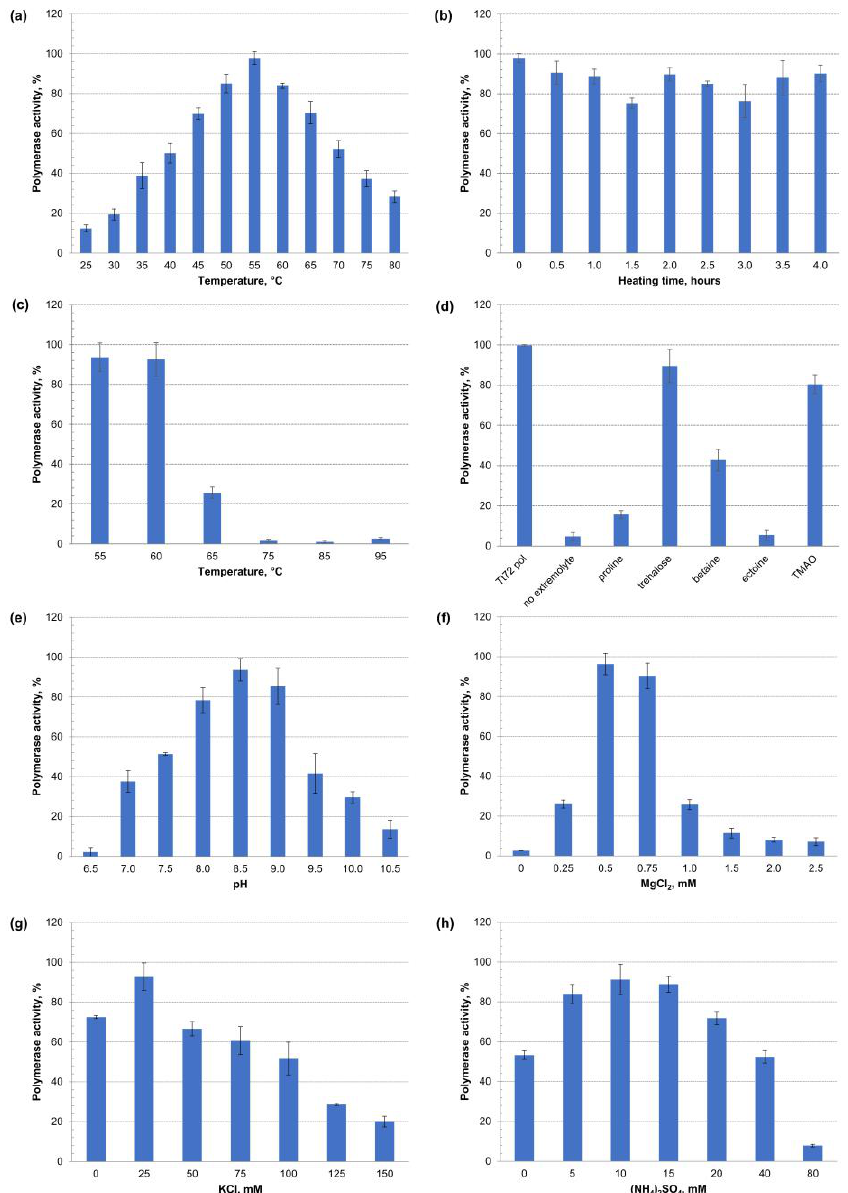
Figure 8. Characterization of Tt72 pol activity optima. Enzyme activity was estimated by measuring the incorporation of radiolabeled nucleotide [ 3 H]-dTTP into activated calf thymus DNA at 55 ◦ C; identical aliquots of Tt72 pol were assayed in three independent sample replicates for each experiment. The variable factors were ( a ) temperature (25–80 ◦ C), ( b ) heating time at 55 ◦ C (0–4 h), ( c ) incubation for 10 min at 55–95 ◦ C, and ( d ) heat shock for 10 min at 75 ◦ C in the presence of compatible solutes, such as proline, trehalose, betaine, ectoine, and TMAO at a concentration of 0.5 M. ( e ) pH range (6.5–10.5), ( f ) MgCl 2 concentration (0–2.5 mM), ( g ) KCl concentration (0–150 mM), and ( h ) (NH 4 ) 2 SO 4 concentration (0–80 mM). Y-axis shows the percent of polymerase activity to maximal activity. Error bars represent SD from the mean.